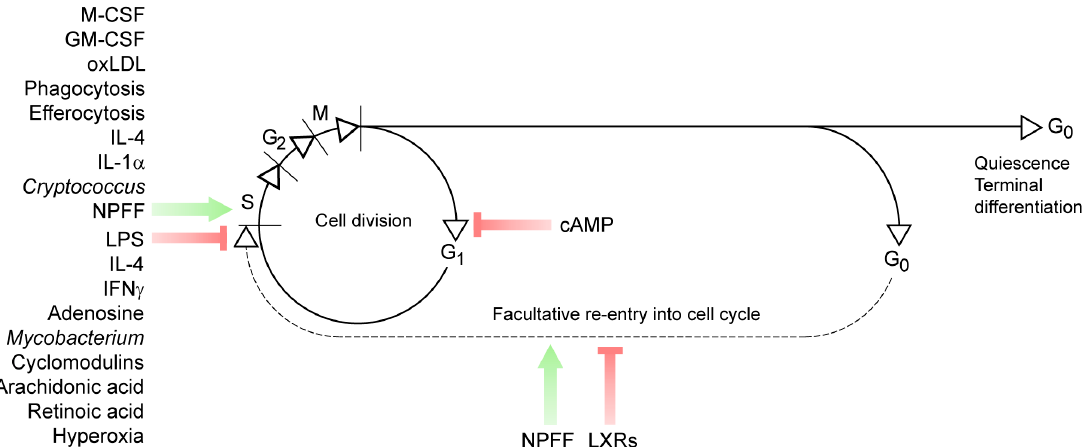
Figure 3. Signals affecting macrophage cell cycle. The scheme summarizes known signals that impede or facilitate cell cycle entry and cell cycle progression in macrophages. M-CSF: macrophage